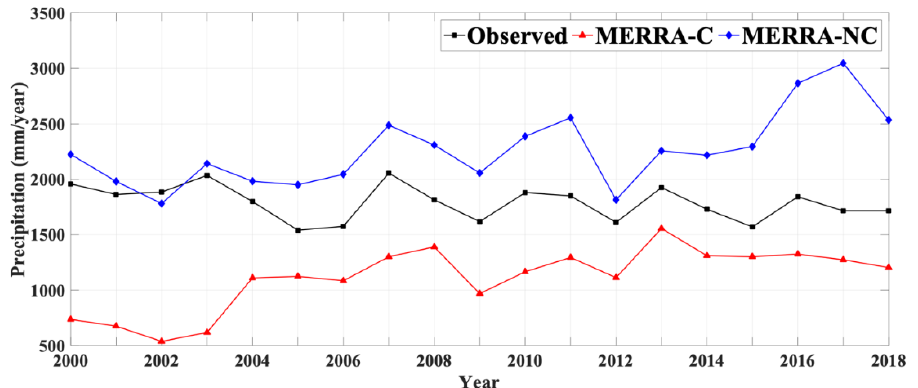
Figure A1. Inter-annual variation of precipitation (mm / year) in observation and both MERRA-2 datasets average over the study area through the study period (2000-2018).